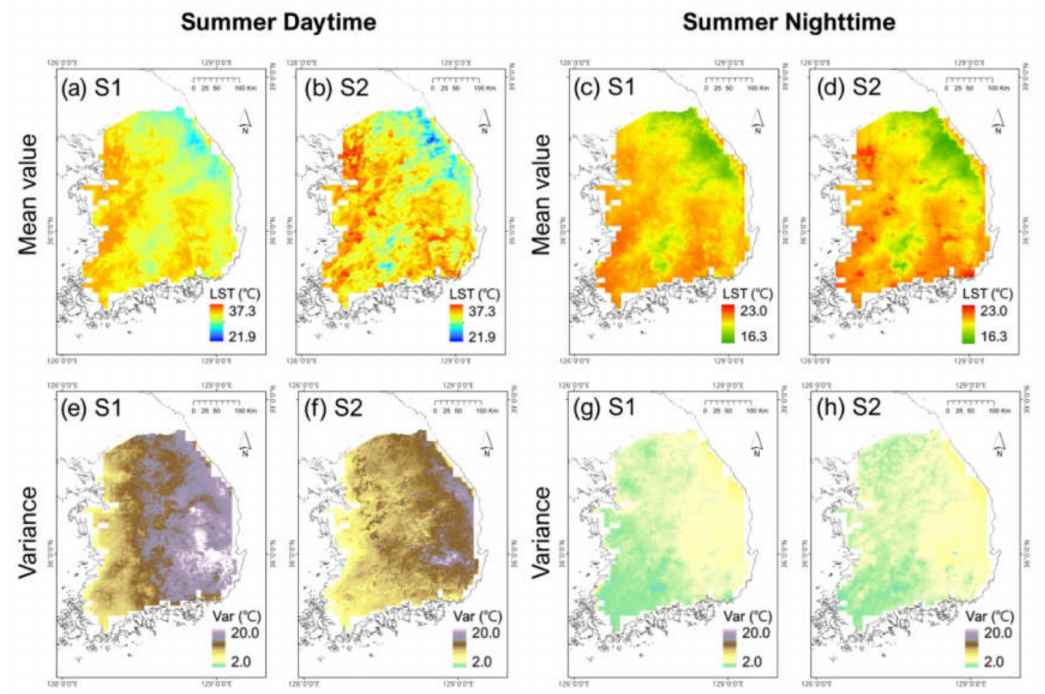
Figure 9. Spatial distribution maps of average all-weather 1 km LSTs (upper) and the variance (lower) during July and August from 2013 to 2018 produced by the two schemes (S1 and S2) for daytime ( a , b , e – f ) and nighttime ( c , d , g – h